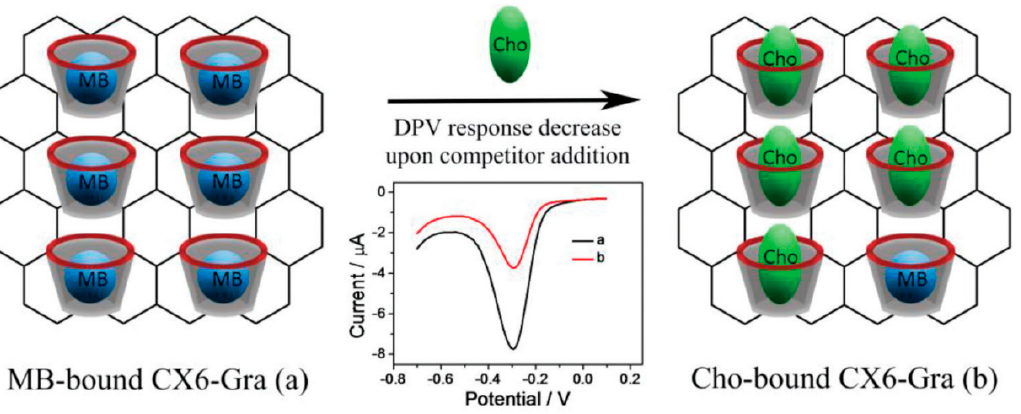
Figure 19. Schematic illustration of host–guest molecular detection of cholesterol (Cho) using CX6– Gra against MB. Reprinted with permission from Ref. [102].